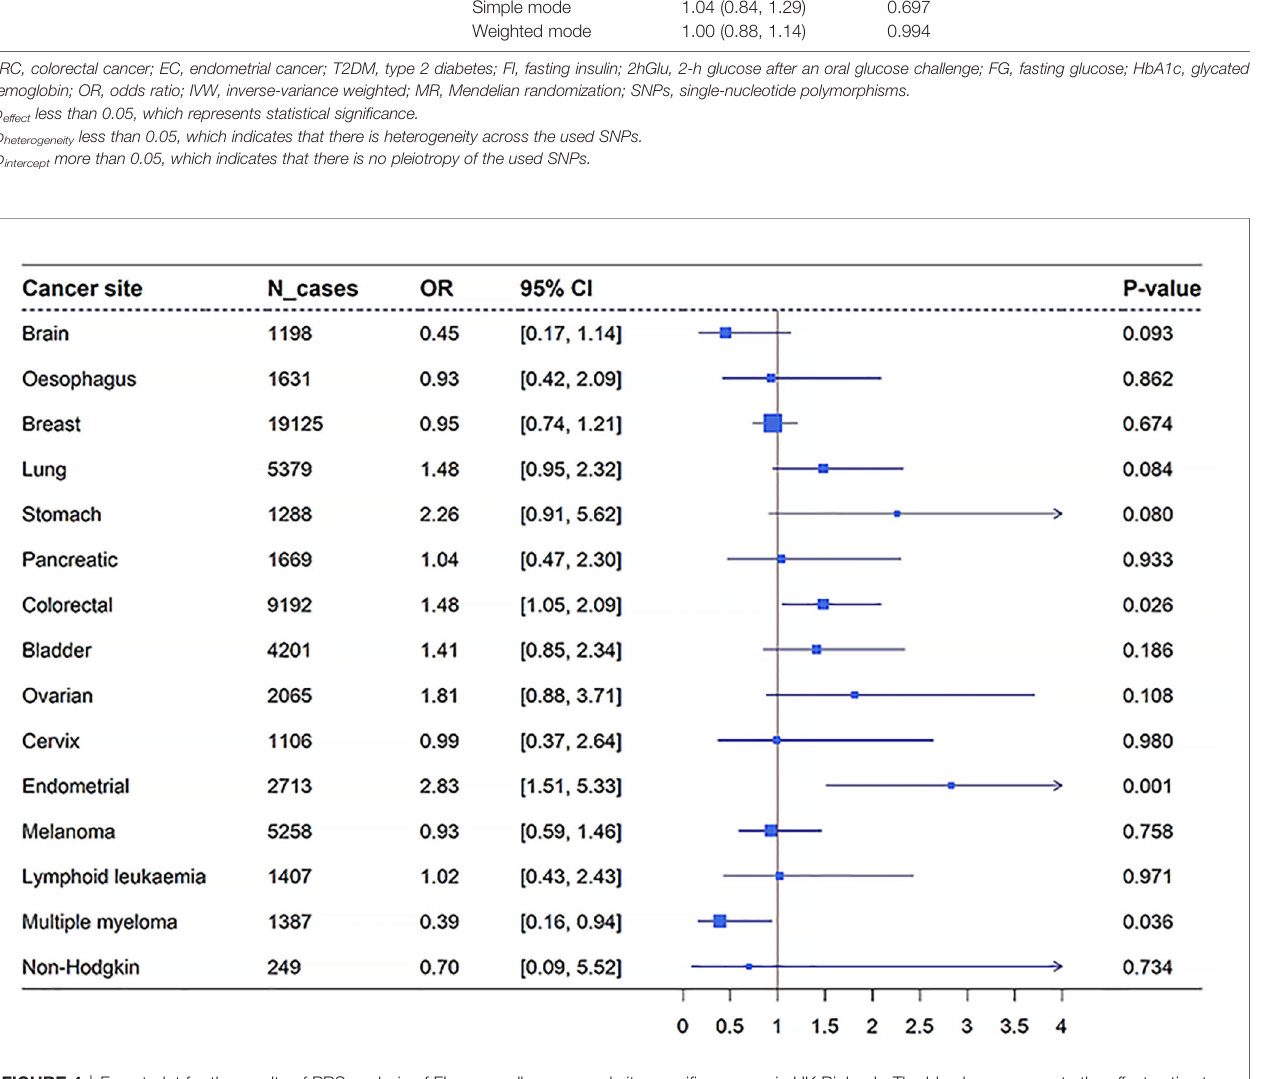
FIGURE 4 | Forest plot for the results of PRS analysis of FI on overall cancer and site-speci fi c cancers in UK Biobank. The blue box represents the effect estimates, and the blue error line represents the 95% CI. OR, odds ratio; PRS, polygenic risk score; FI, fasting